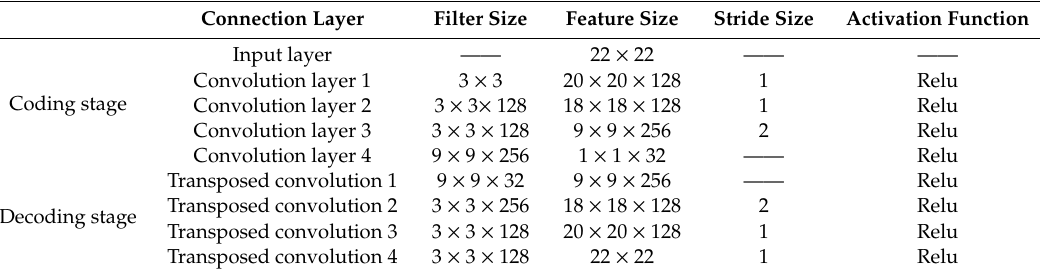
Figure 15. Iterative loss function curve of the deep convolution auto-encoder. Table 1. Deep convolutional auto-encoder construction.